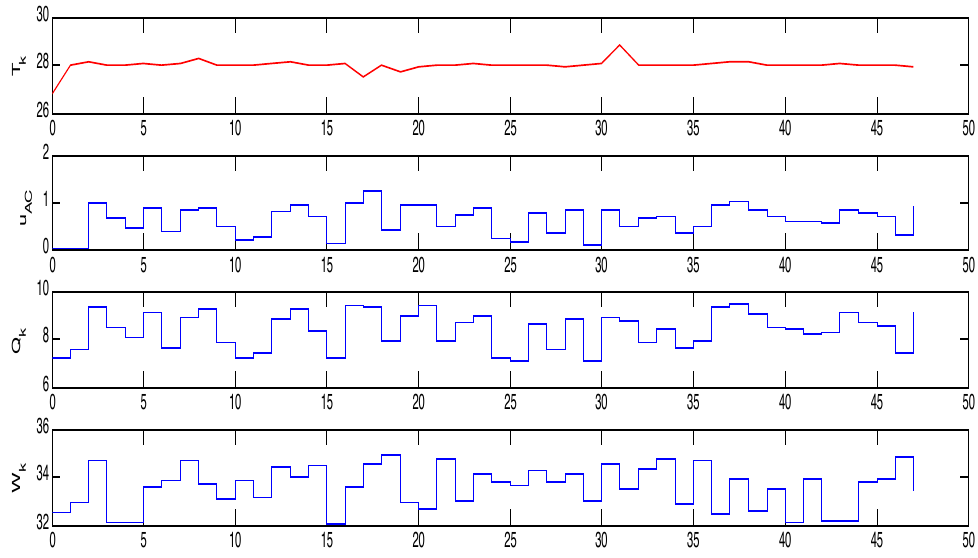
Figure 12. Variations in zone temperature, control input, heating due to cooling load, and ambient temperature ( x -axis: 1 unit = 15